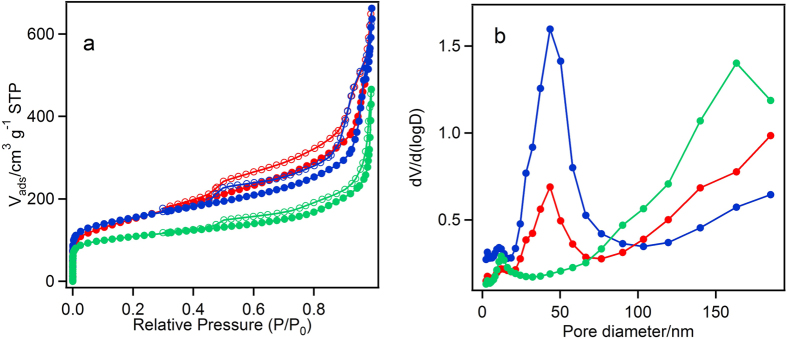
(a) N2 adsorption (closed circle) and desorption (open circle) isotherms and (b) the pore size distribution of MgOCs analysed by the BJH method. MgOCmeso (blue), MgOCmacro (green), MgOC50 (red).